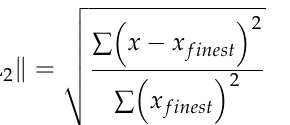
(cid:0) (cid:1) r − 1 as well as the resulting surface tension γ